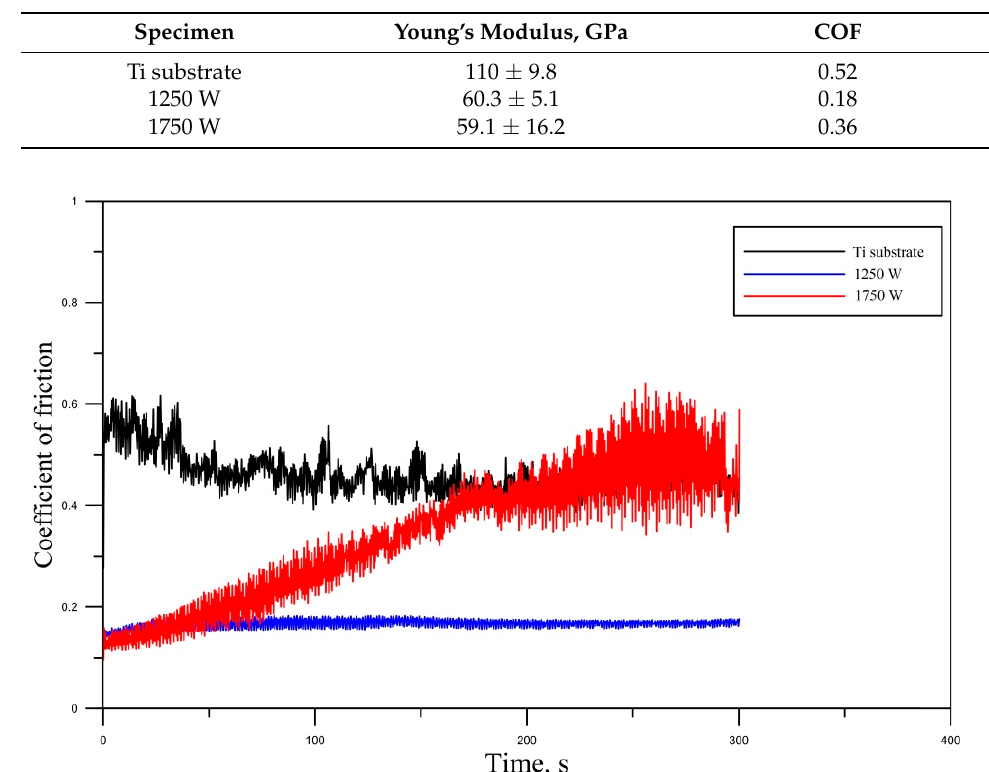
Figure 8. Friction coefficients of the Ti substrate and the Ti–Ta surface alloys formed by a beam power of 1250 and 1750 W.